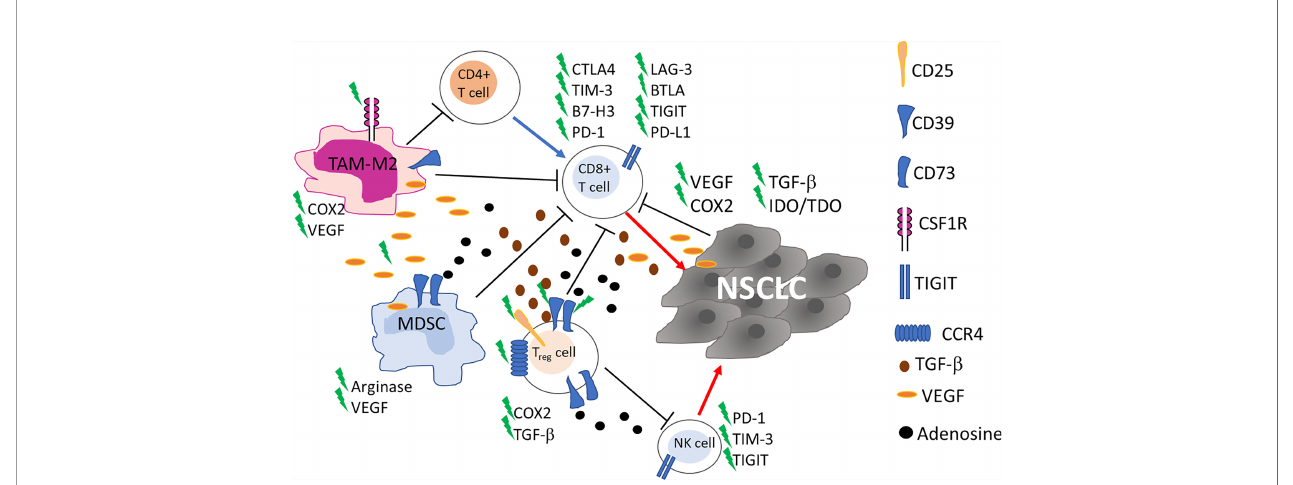
FIGURE 1 | Schematic representation of the main cells in tumor microenvironment involved in NSCLC resistance to ICI. Up-regulation of alternative immune checkpoints on cytotoxic CD8+ T cells impairs recognition and killing of tumor cells. Myeloid derived suppressor cells (MDSC), tumor associated macrophages (TAM)-M2 and CD4+ T Regulatory (Treg) cells through cytokine and soluble factors contribute to the inhibition of the immune responses. Blue and red arrows indicate stimulation and killing, respectively. New targets for on-going clinical trials are highlighted by a green fl